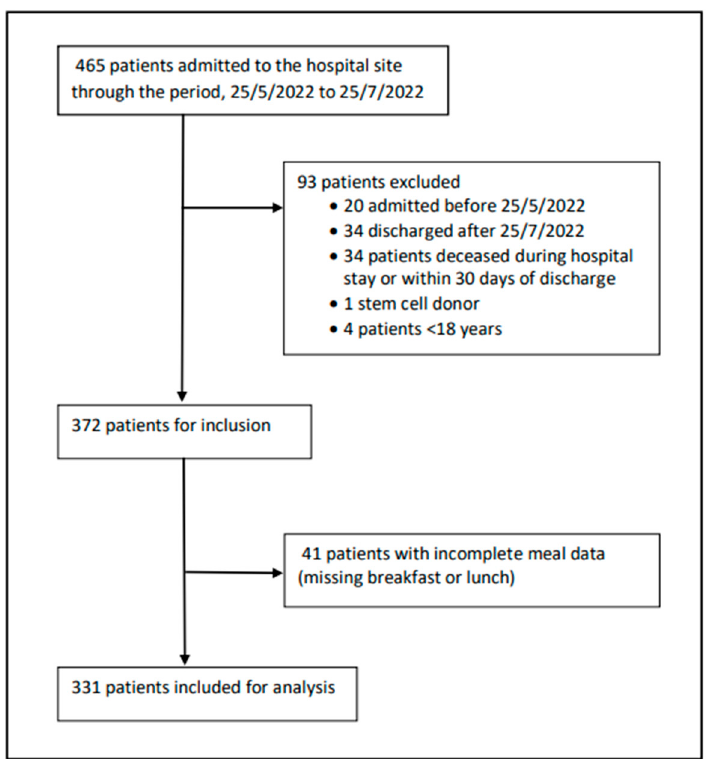
Figure 1. Flow chart of participant inclusion.